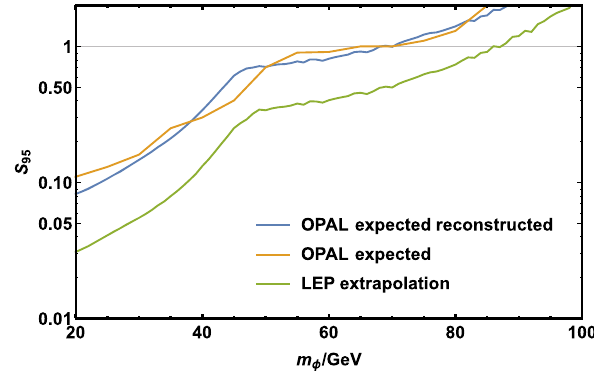
Fig. 2 The expected limit from OPAL based on the recoil method is compared with our method for approximately reconstructing the expected limit for S 95 , which makes use of the two scaling factors c recoil given in Table 2. Also shown is our result where the luminosity has been extrapolated to the full LEP luminosity to obtain the event rates for background, b i ≡ b i ( m